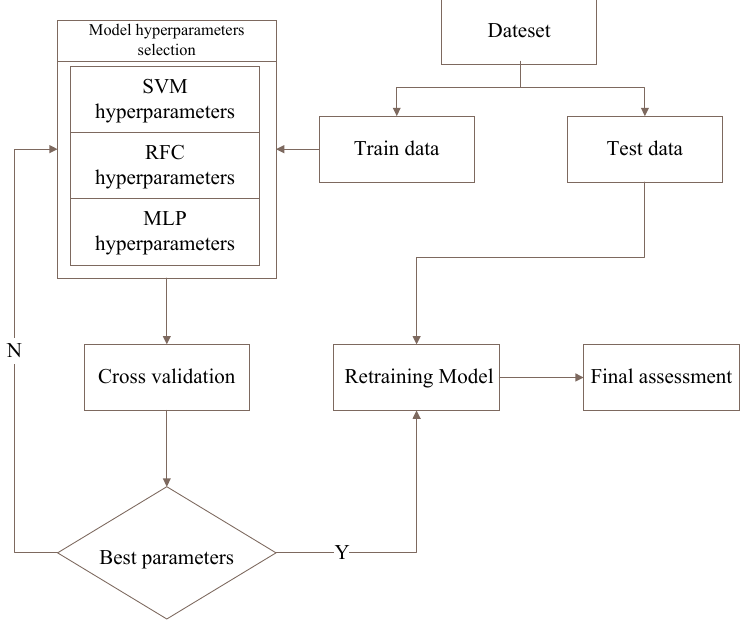
Figure 2. Schematic of the overall parameter selection and model training process.